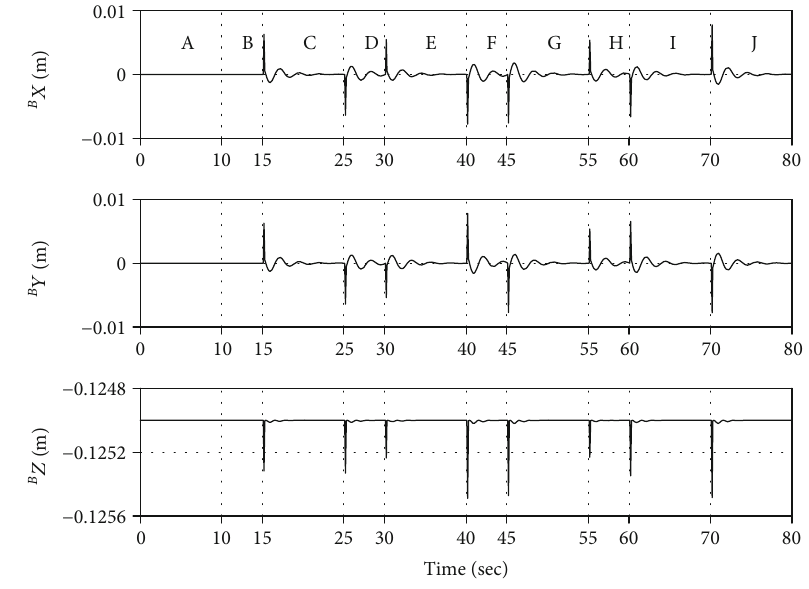
Figure 15: Position of the moving part w.r.t.